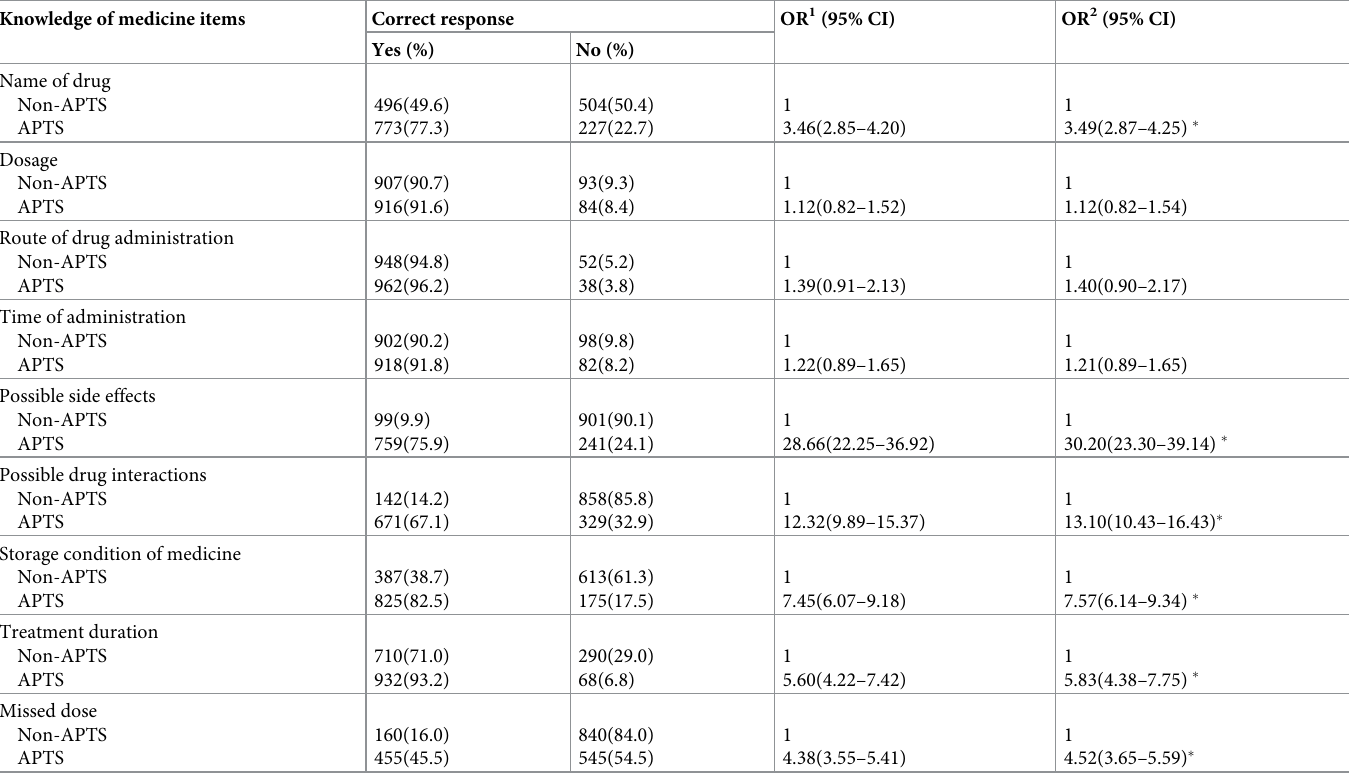
Table 4. Comparison of patients’ knowledge on prescribed medicines in APTS and Non-APTS primary level hospitals: Univariable and Multivariable Logistic Regressions. Knowledge of medicine